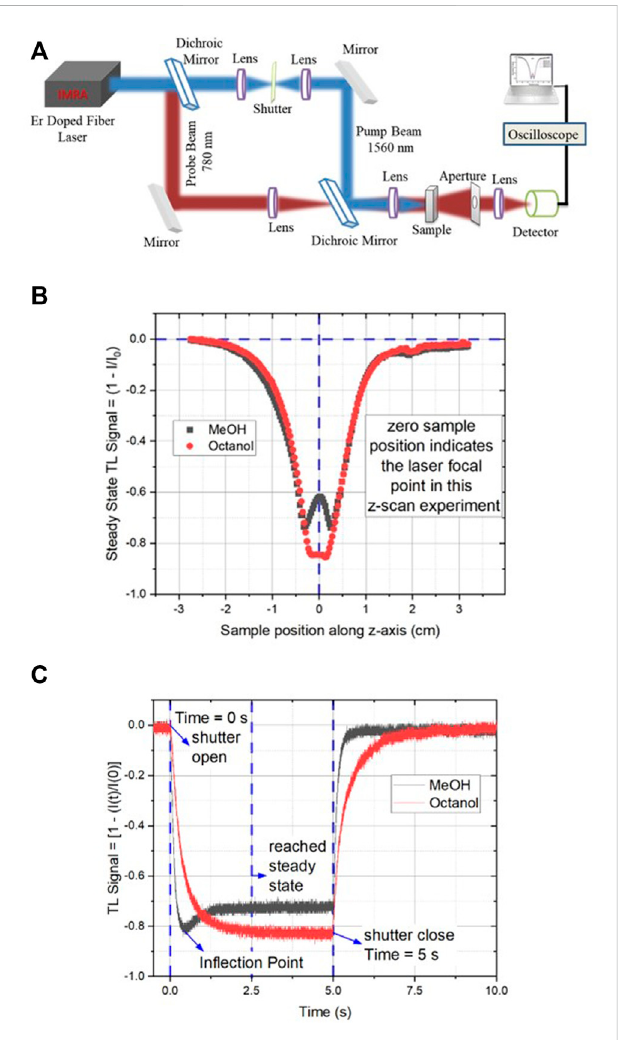
FIGURE 7 Femtosecond thermal lens (TL) spectroscopy with dual laser beams: (A) Experimental setup for both stationary as well as time- resolved TL measurements with high-repetition-rate lasers in a dual- beam experimental con fi guration. (B) Typical steady-state TL signals for dual-beam experiments for two different samples were collected as a function of sample position across the focal point of the TL-inducing laser. Drastic molecular dependence of TL is evident between methanol and octanol. (C) The corresponding time-resolved TL signal shows the molecular distinction in femtosecond TL. The in fl ection point indicates the importance of convection effects in addition to the conduction models that are molecule insensitive.